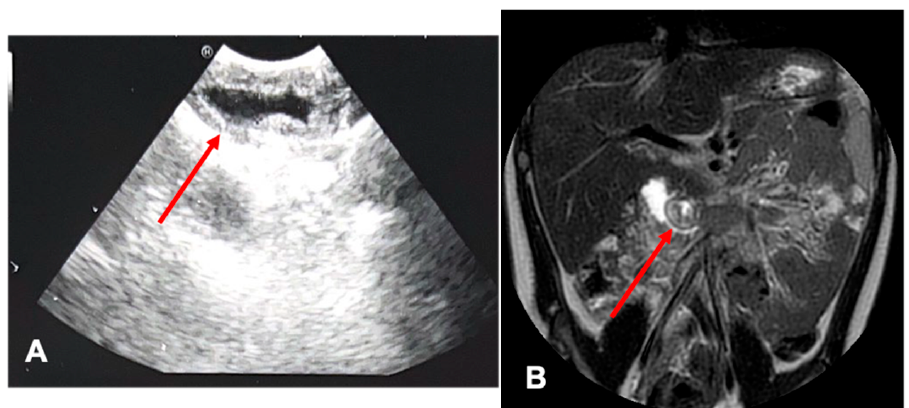
Figure 1. ( A , B ) Endoscopic US ( A ) and MRI ( B ) evaluation. Duodenal duplication in patient n. 7 (red arrows) with a cystic lumen surrounded by multiple layers, well evident on endoscopic US scan.